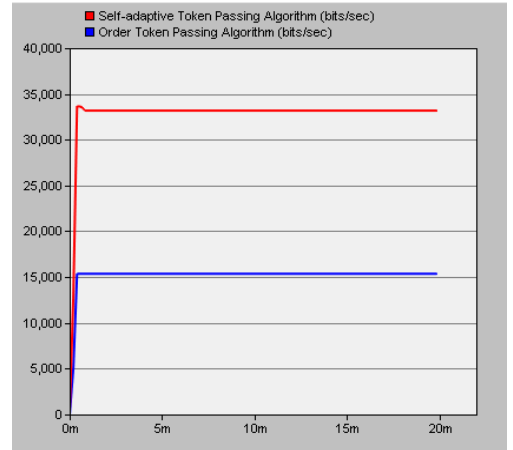
Fig.5 Improvement on network throughput.